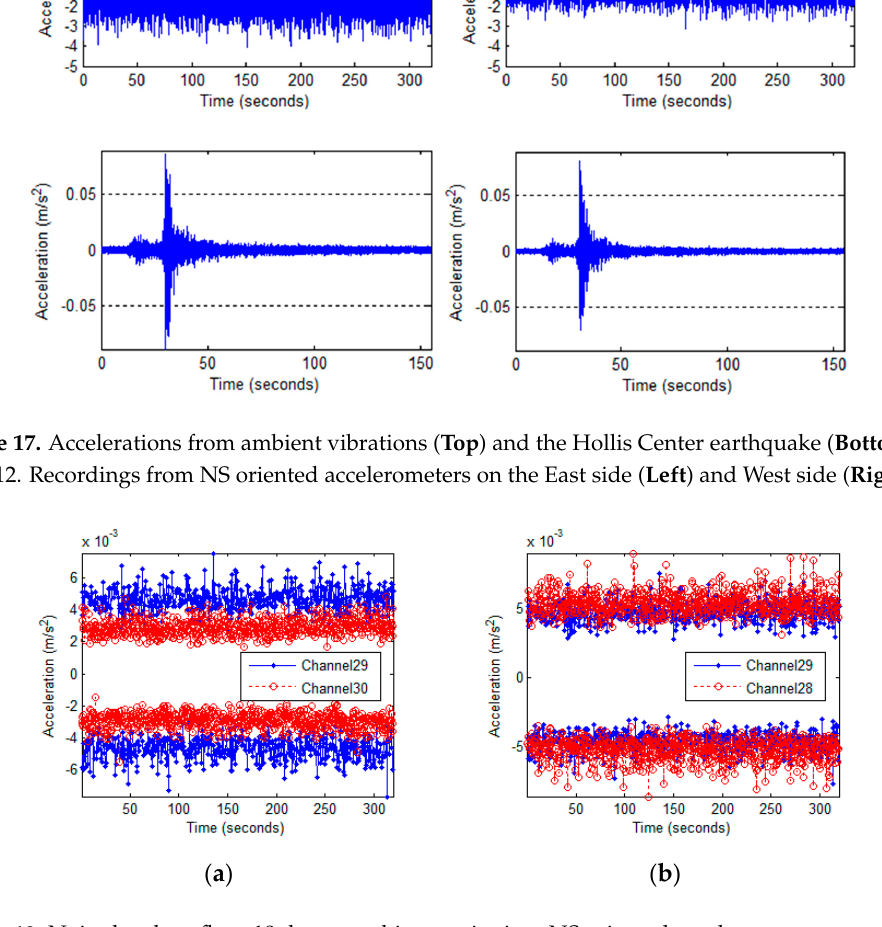
Figure 18. Noise levels at floor 18 due to ambient excitation. NS oriented accelerometers at opposite sides of the floor ( a ) and NS and EW oriented accelerometers at the eastern side ( b ). Table 3. Comparison of peak accelerations between parallel NS oriented accelerometers at floor 18 due to various excitations.